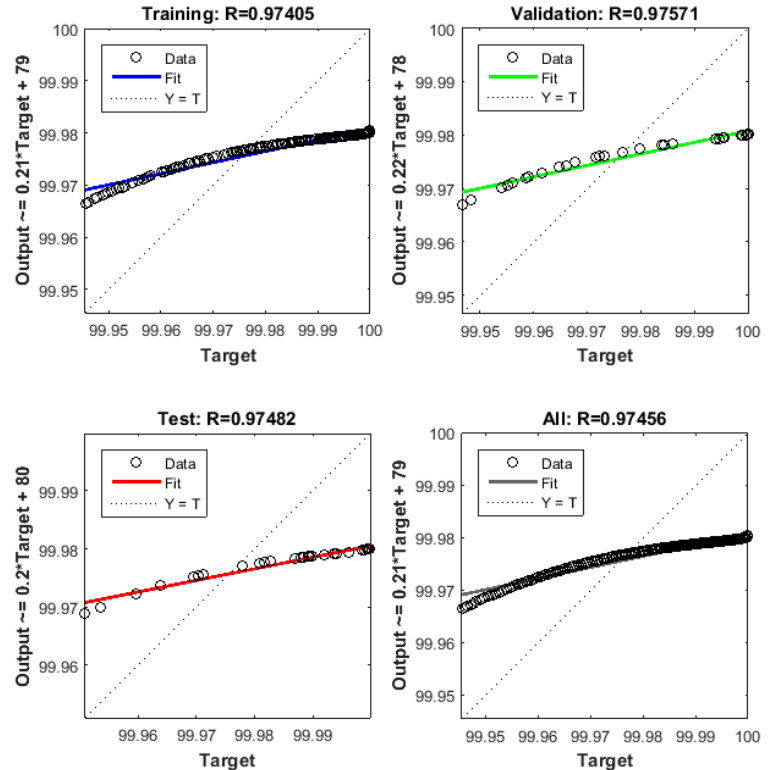
Figure 19. Training, testing, and validation results with regression.